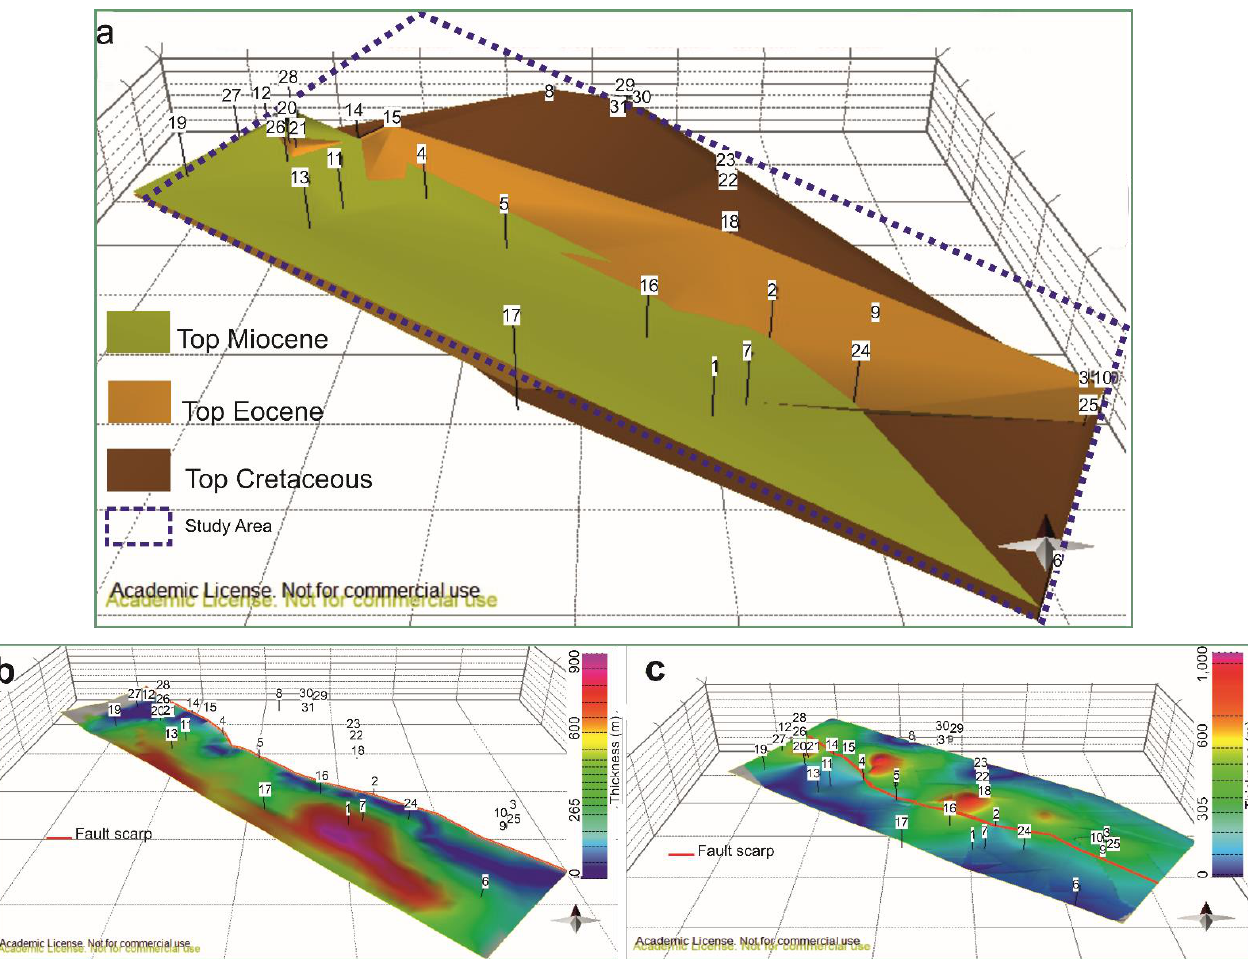
Figure 7. ( a ) Three-dimensional geometry of the Top Miocene, Top Eocene, and Top Cretaceous surfaces from well log data interpretation. The three surfaces form angular unconformities. ( b ) Thick- ness distribution of the Miocene stratigraphic interval was calculated considering both Top Miocene and Top Eocene surfaces. ( c ) Thickness of the Eocene stratigraphic interval calculated considering both Top Eocene and Top Cretaceous surfaces. In the latter figures, the trace of the main fault scarp identified in the isochron map (downloaded from the ViDEPI website) is